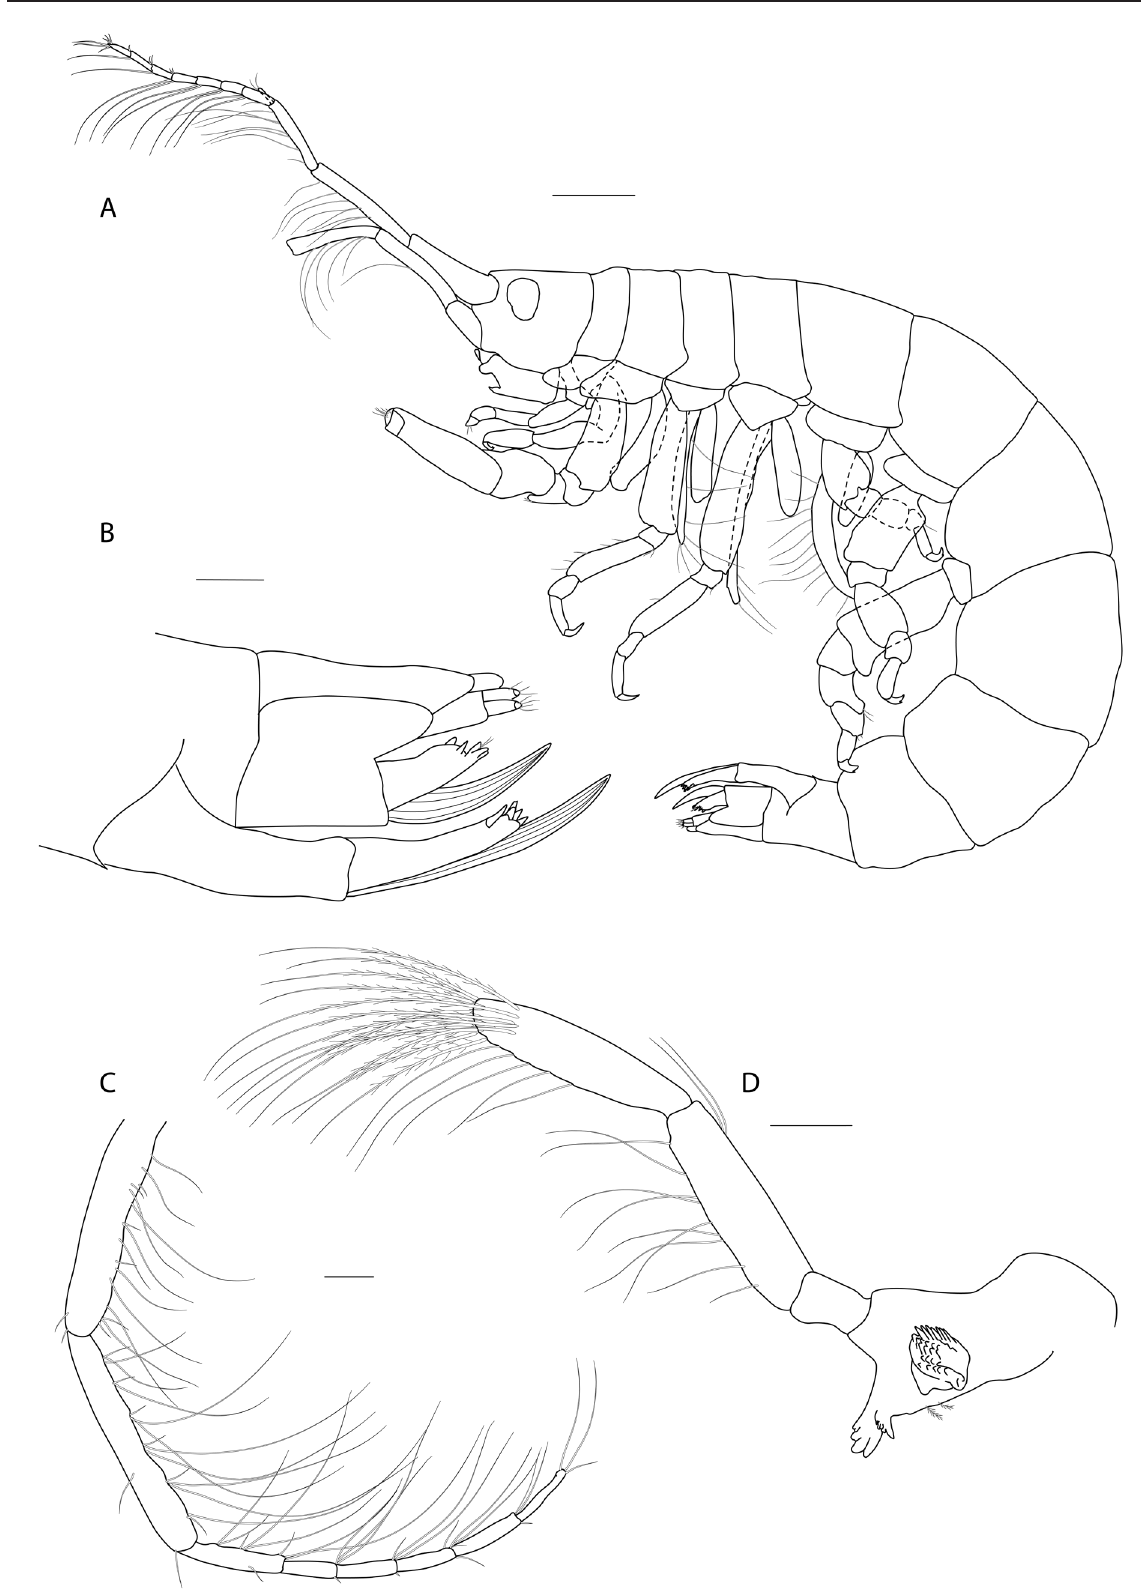
Fig. 3. Bryoconversor tutus gen. et sp. nov., holotype, ♀, NIWA 88918, 1.72 mm long. A . Habitus. B . Urosome. C . Antenna 2. D . Mandible. Scale bars = 100 μ